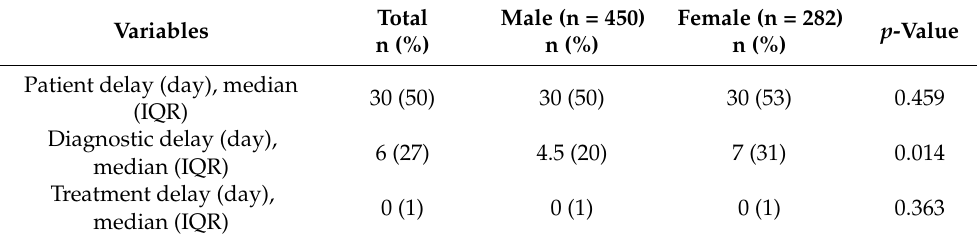
Table 1. Sociodemographic characteristics, lifestyle, co ‐ morbidities, clinical presentation, knowledge about pulmonary tuberculosis, stigma, and healthcare ‐ seeking behavior of the patients stratified by gender (n = 732).